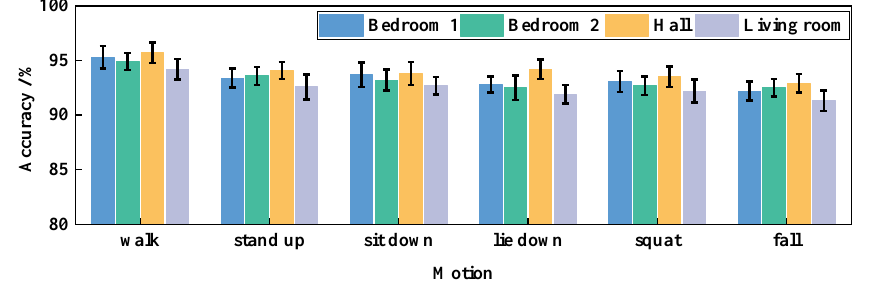
Figure 10. Cross-domain performance comparison.